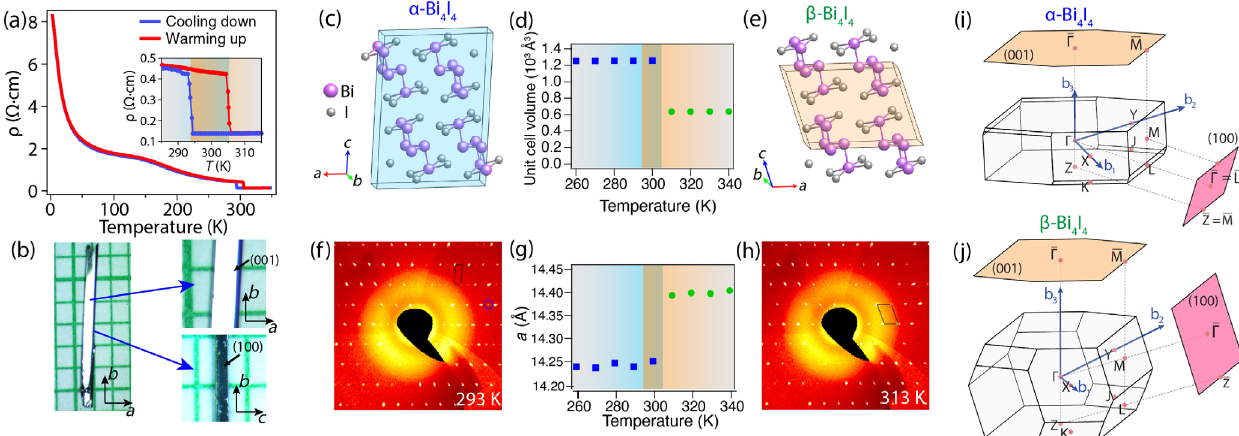
FIG. 1. Crystal structure and sample characterization. (a) Temperature-dependent resistivity data for both cooling and warming curves. The inset is the enlarged view showing the hysteresis behavior of the first-order transition. (b) Images of a Bi 4 I 4 crystal showing the cleavable (001) and (100) surfaces where the grid is 1 mm. (c),(f) The real-space crystal structure and the reciprocal space lattice from the h 0 l layer precession images integrated from x-ray diffraction data for the α -Bi 4 I 4 phase. The shaded region is the structural unit cell. (d),(g) The unit cell volume and refined lattice parameter a from x-ray diffraction reflecting the α to β structural transition. (e),(h) Same as (c),(f) but for the β -Bi 4 I 4 phase. (i),(j) The bulk and projected surface Brillouin zones (BZ) of α -Bi 4 I 4 and β -Bi 4 I 4